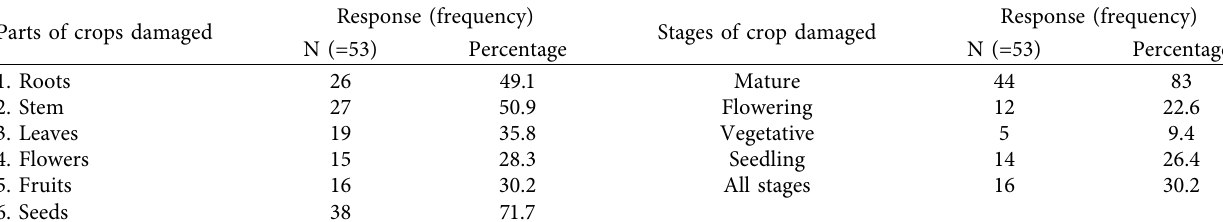
Table 8: Parts and stages of crops damaged by wild